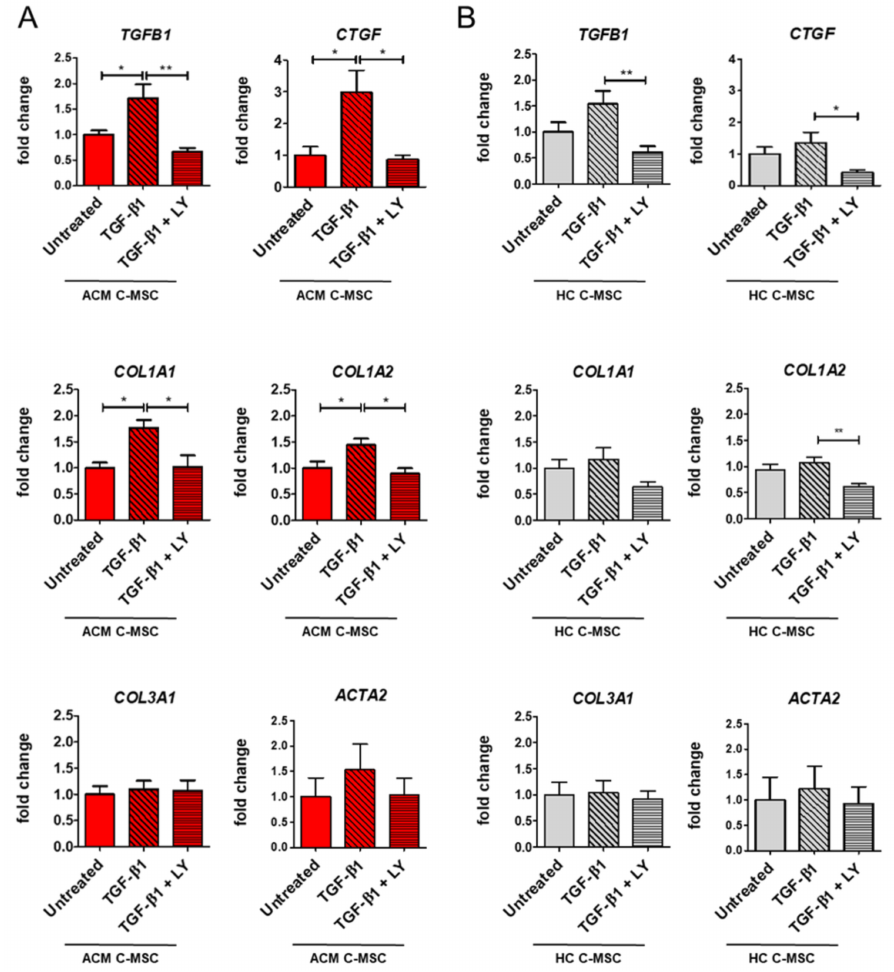
Figure 3. Effect of TGF- β 1 stimulation on gene expression of pro-fibrotic markers. C-MSC isolated from HC donors and ACM patients were grown in low serum (2%) overnight and were stimulated or not with TGF- β 1 for 24 h in the presence or absence of LY364947 treatment. Comparison of fibrosis-associated gene expression ( TGFB1, CTGF, COL1A1, COL1A2, COL3A1, ACTA2 ) in total RNA extracts from ACM ( A ) and HC C-MSC ( B ). GAPDH was used as a house-keeping gene and qRT-PCR data are presented as the fold change of target gene expression with respect to the untreated. n = 3/group. One-way ANOVA and Bonferroni’s post-test: * p < 0.05, ** p <